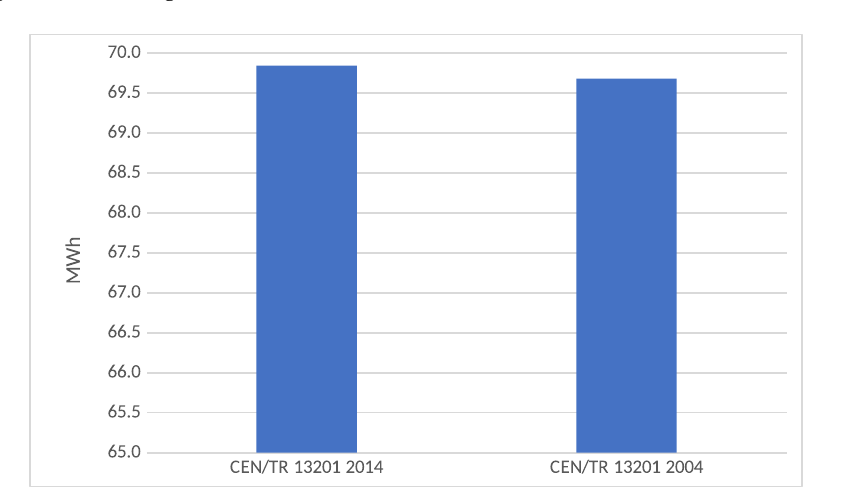
Figure 2. Overall energy consumption when using 2004 and 2014 standards without dynamic control.